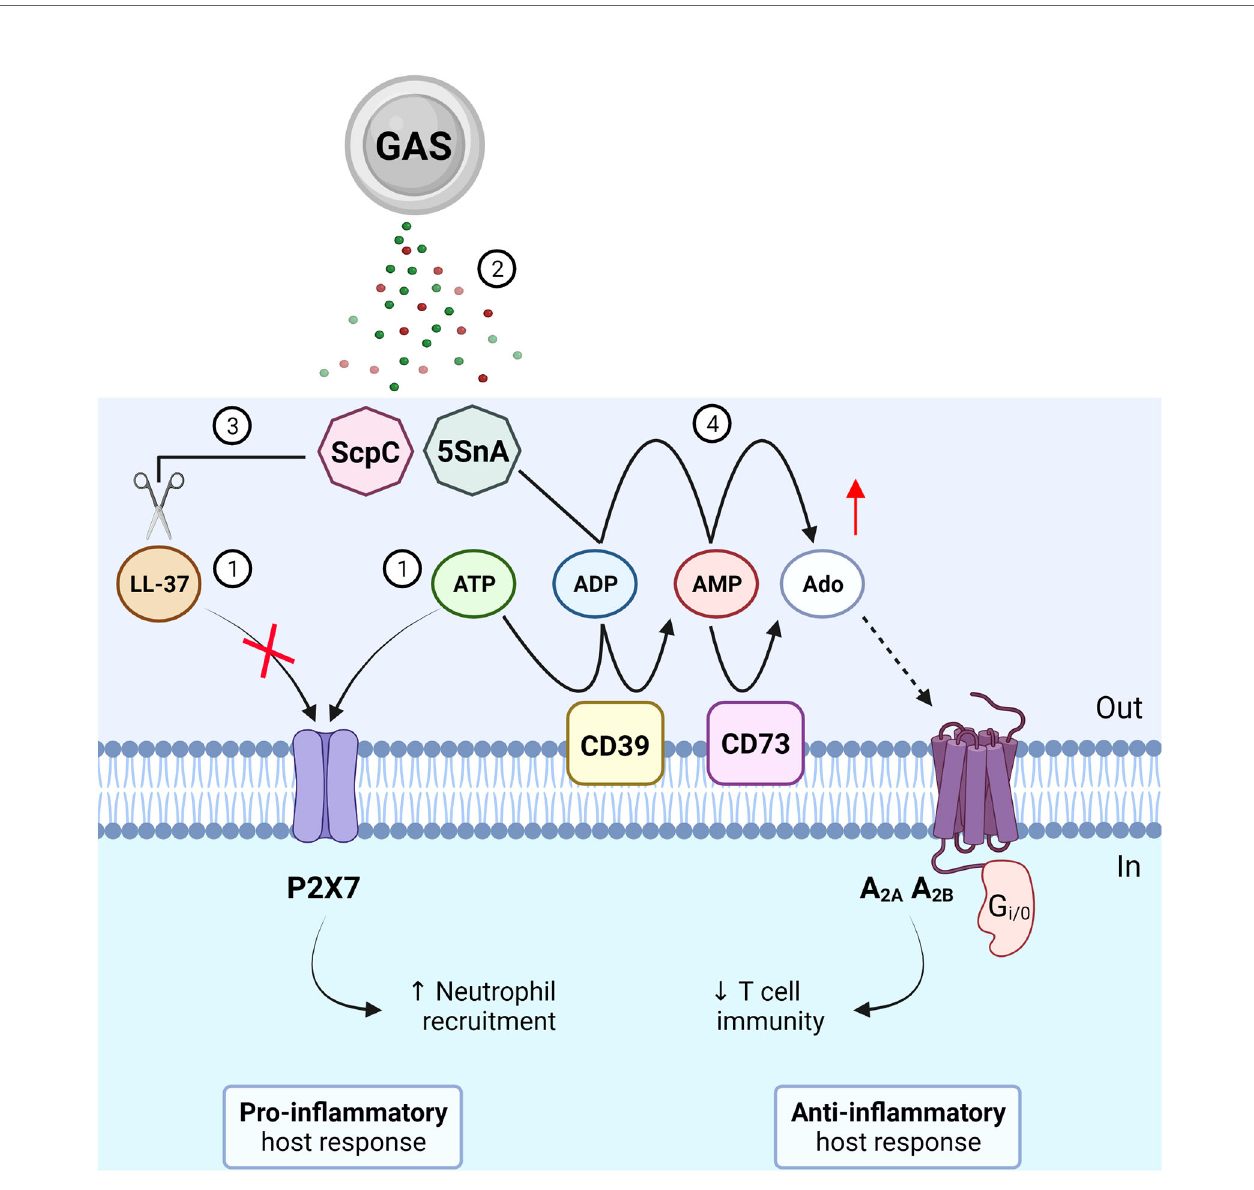
FIGURE 1 | Roles of purinergic signalling in Group A Streptococcus (GAS) immunity and evasion. (1) GAS causes the release of LL-37 and ATP, which can activate P2X7 to promote neutrophil recruitment and protection from GAS infection. (2) GAS secretes virulence factors, ScpC and streptococcal 5 ’ -ectonucleotidase A (5SnA). (3) ScpC can cleave LL-37 to prevent P2X7 activation and promote immune evasion including reduced neutrophil recruitment. (4) 5SnA can hydrolyse ADP and AMP to increase extracellular adenosine (Ado), mimicking the action of host ectonucleotidases (CD39 and CD73), to activate P1 receptors (A 2A and A 2B ) and potentially restrain T cell immunity and promote immune evasion. Created with